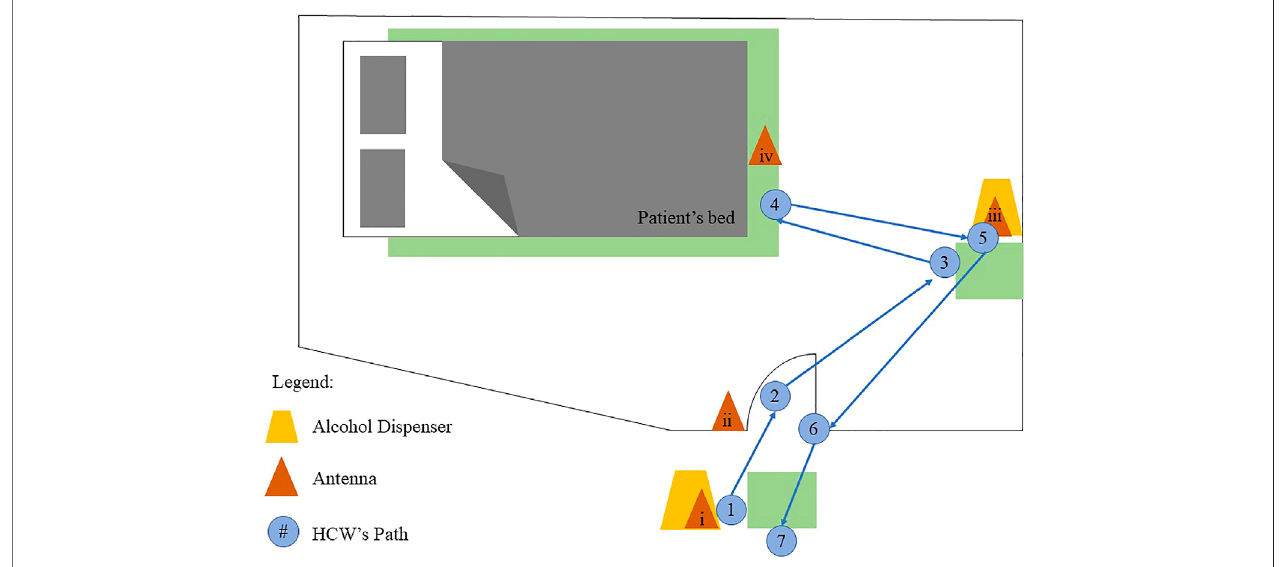
FIGURE 1 | Antennae placement within patient room (adopted from Boudjema et al., 2013).